Question: Draft a figure caption describing what is shown.
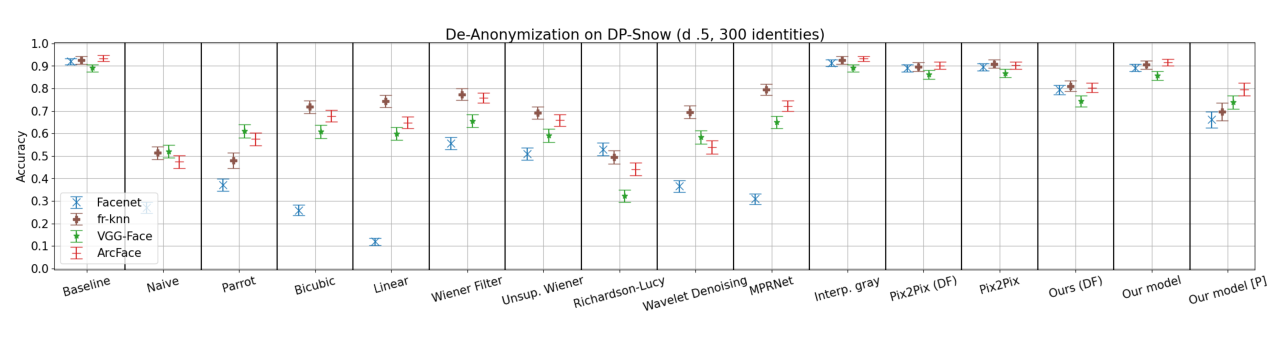
Answer: Recognition accuracy for DP Snow, given for baseline, naive, parrot, de-anon. via bicubic interpolation, via linear interpolation, via Wiener Filter, via unsupervised Wiener Filter, via Richardson-Lucy interpolation, via Wavelet Denoising, via MPRNet (Denoising), via Interpolate Gray, via Pix2Pix trained on DigiFace-1M, via Pix2Pix, via our model trained on DigiFace-1M, via our model; on 300 identities of CelebA.